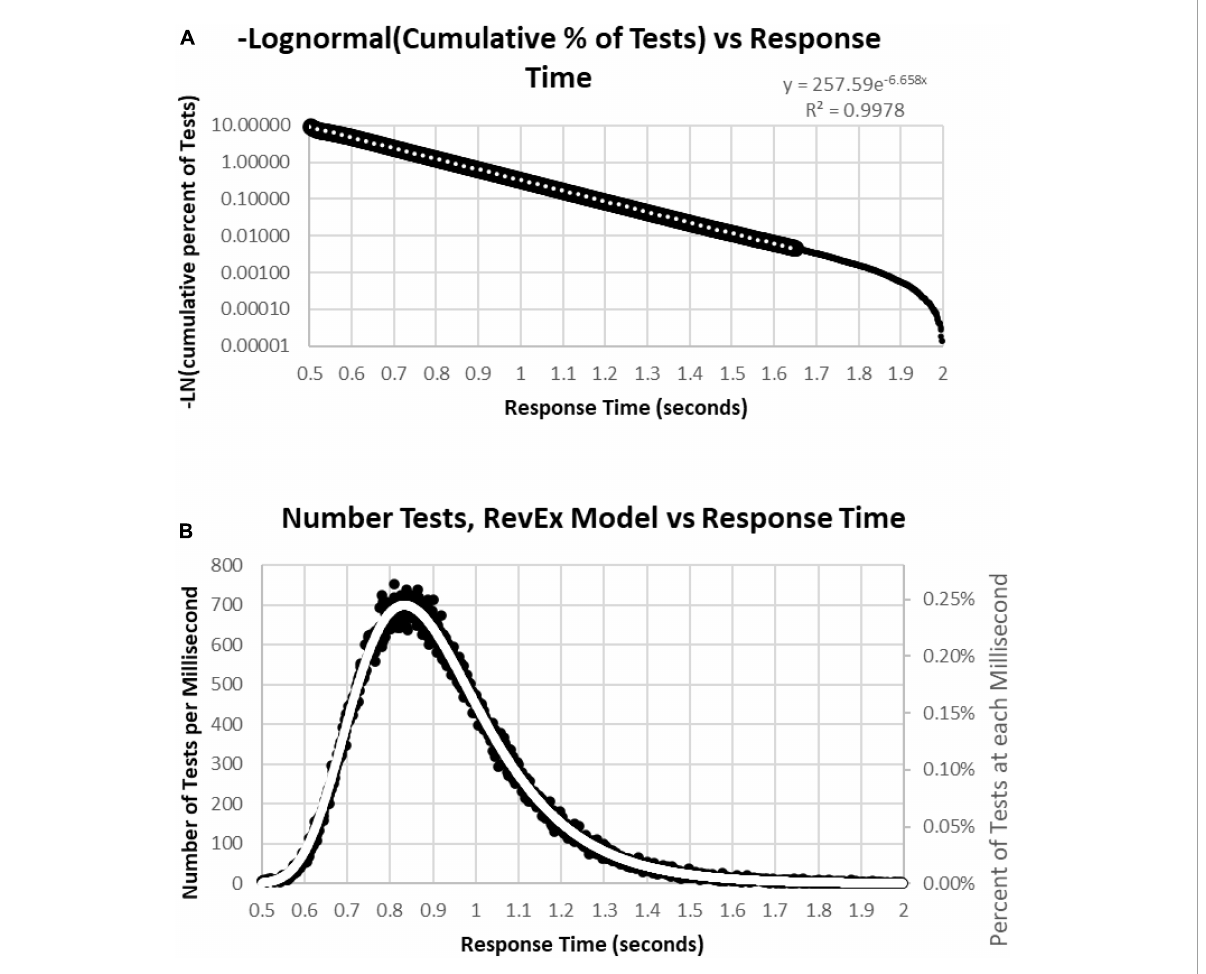
FIGURE8 (A) Negative natural logarithm of the cumulative percentage of RTs plotted against the RT. The Pearson regression exponential curve explained nearly all the variance between 0.5 and 1.65 s. (B) Calculation of exponential curve back to number of RTs. The curve clearly fits the distribution of the RTs. The most responses were at 0.810 s followed by 0.839 and 0.864 s, while the peak of the RevEx model was at 0.833